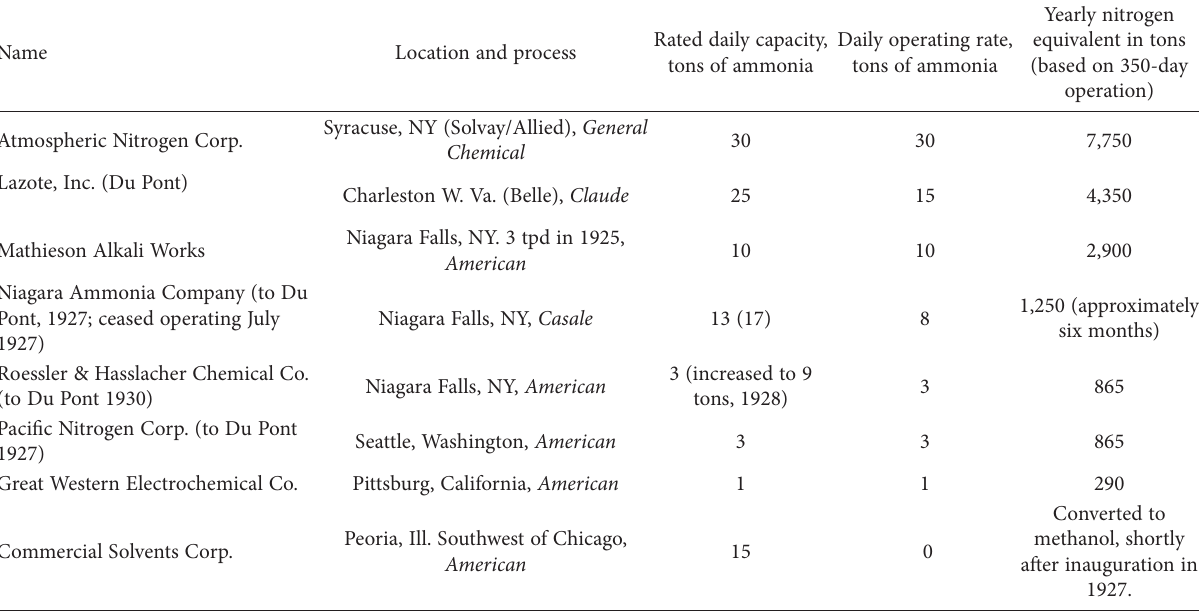
Table 1. Synthetic ammonia facilities, United States,